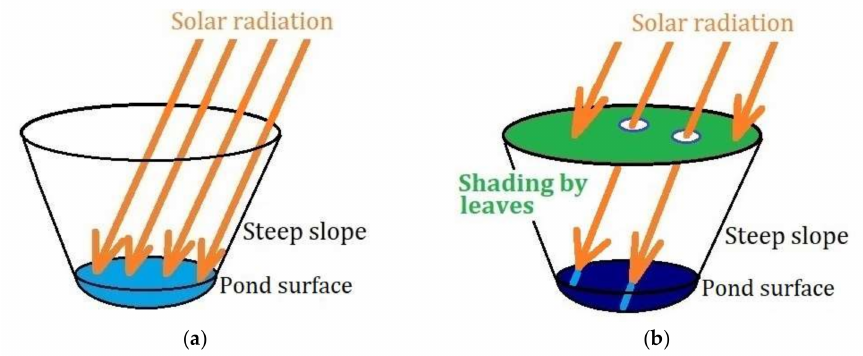
Figure 3. ( a ) Situation surrounded by leaf-free trees on the slope. Most of solar radiation can then pass through the trees. ( b ) Situation surrounded by leaf-growing trees. The shading effect tends to produce a few sunbeams between the leaves.